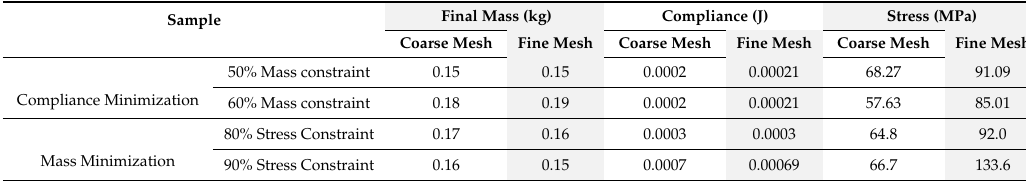
Table 4. Compliance comparison between coarse and fine mesh